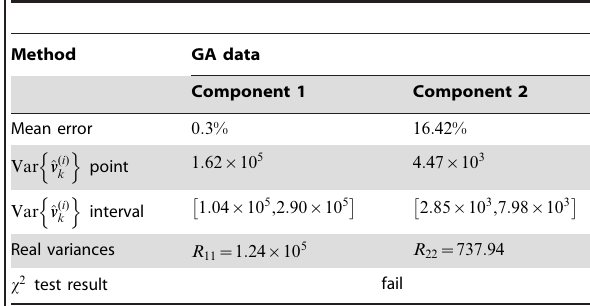
Table 2. x 2 test results for the estimation of 6 parameters in the heat shock model (moment matching).